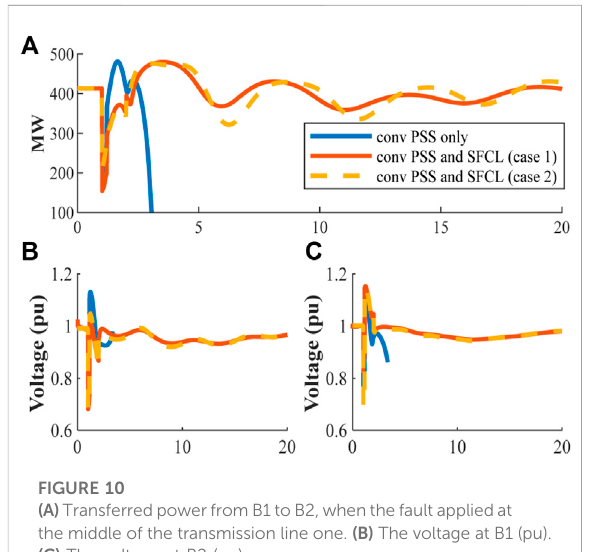
FIGURE 10 (A) TransferredpowerfromB1toB2,whenthefaultappliedat the middle of the transmission line one. (B) The voltage at B1 (pu). (C) The voltage at B2 (pu).